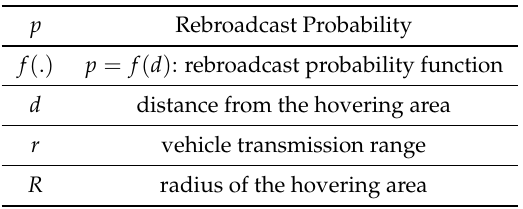
Table 1. Notation used for Protocol